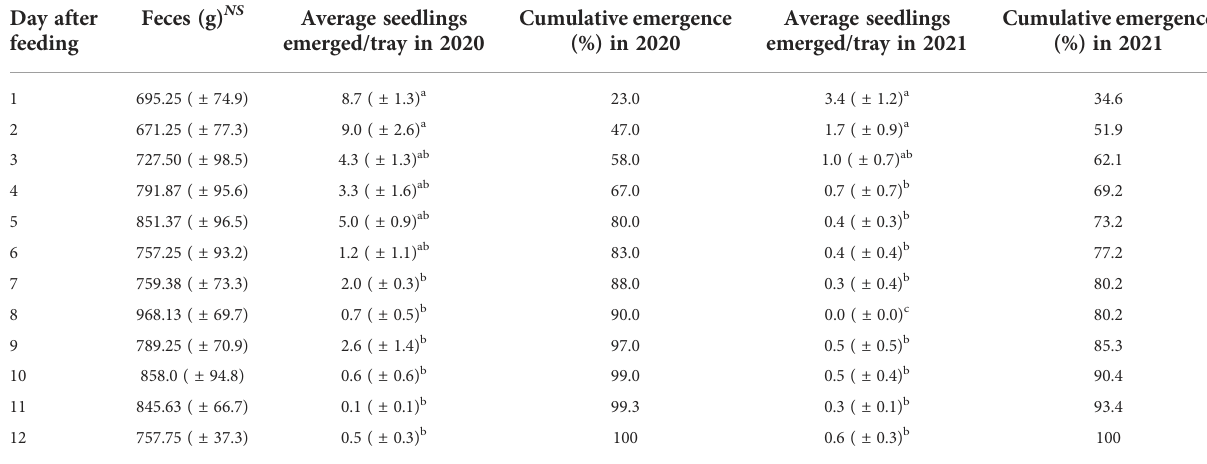
The data show mean value ( ± standard error). Values in the same column with different letters are signi fi cantly different using Tukey ’ s HSD at p<0.05. Seedling emergence signi fi cantly (p<0.05) varied between days after feces collection. NS, Not Signi fi cant.